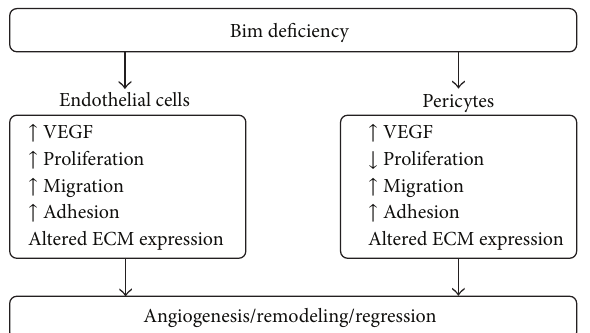
Figure 9: A summary of the modulation of VEGF expression, proliferation, migration, adhesion, and ECM expression in Bim deficient endothelial cells and